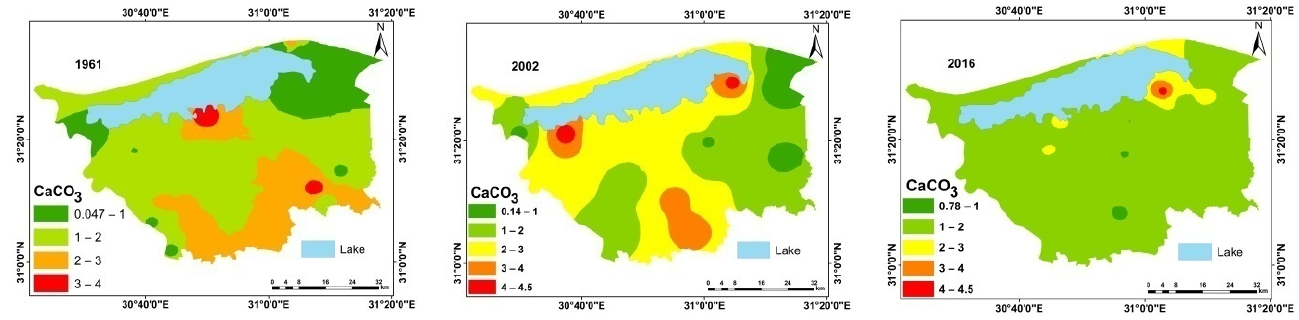
Figure 11. Lime content maps in 1961, 2002, and 2016.